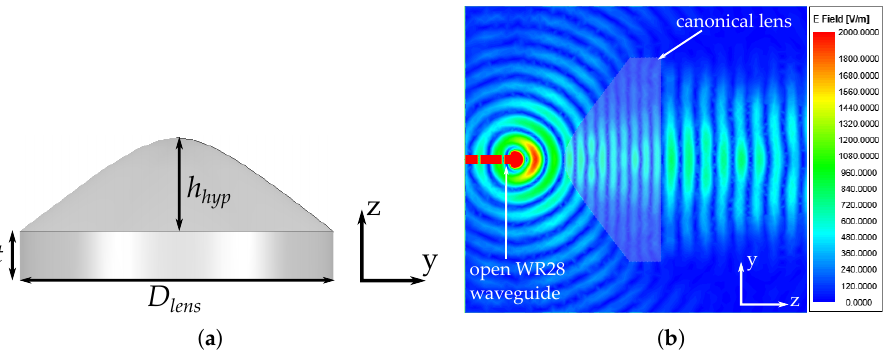
Figure 1. Canonical hyperbolic lens. ( a ) Dimensions. ( b ) Resulting electric field at 30 GHz.